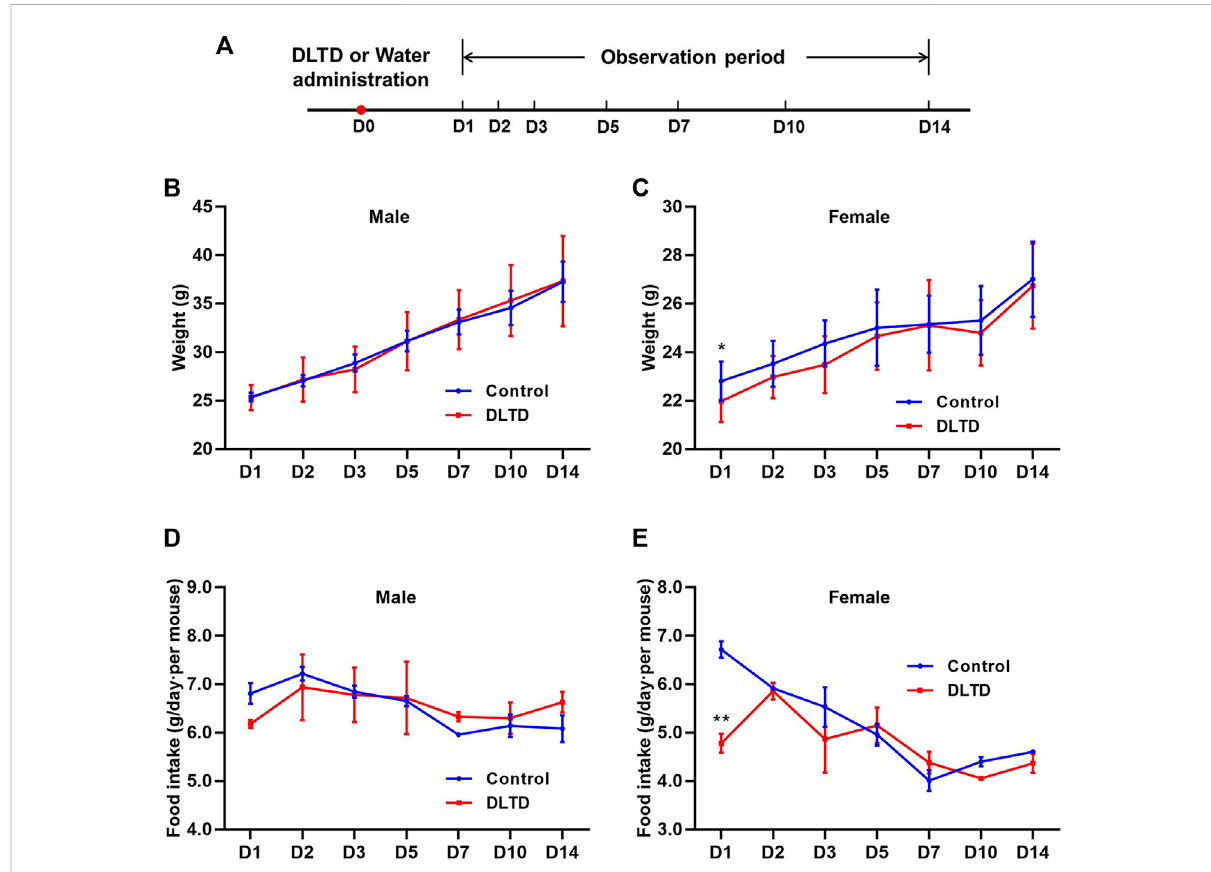
FIGURE 1 Body weight and food consumption of mice in acute toxicity studies. (A) Timeline of the acute toxicity study. Weights of male mice (B) and femalemice (C) intheacutetoxicitystudy.Foodconsumptionofmalemice (D) andfemalemice (E) intheacutetoxicitystudy.Statisticalanalysiswas performed using the t -test. * p < 0.05, ** p < 0.01 versus the